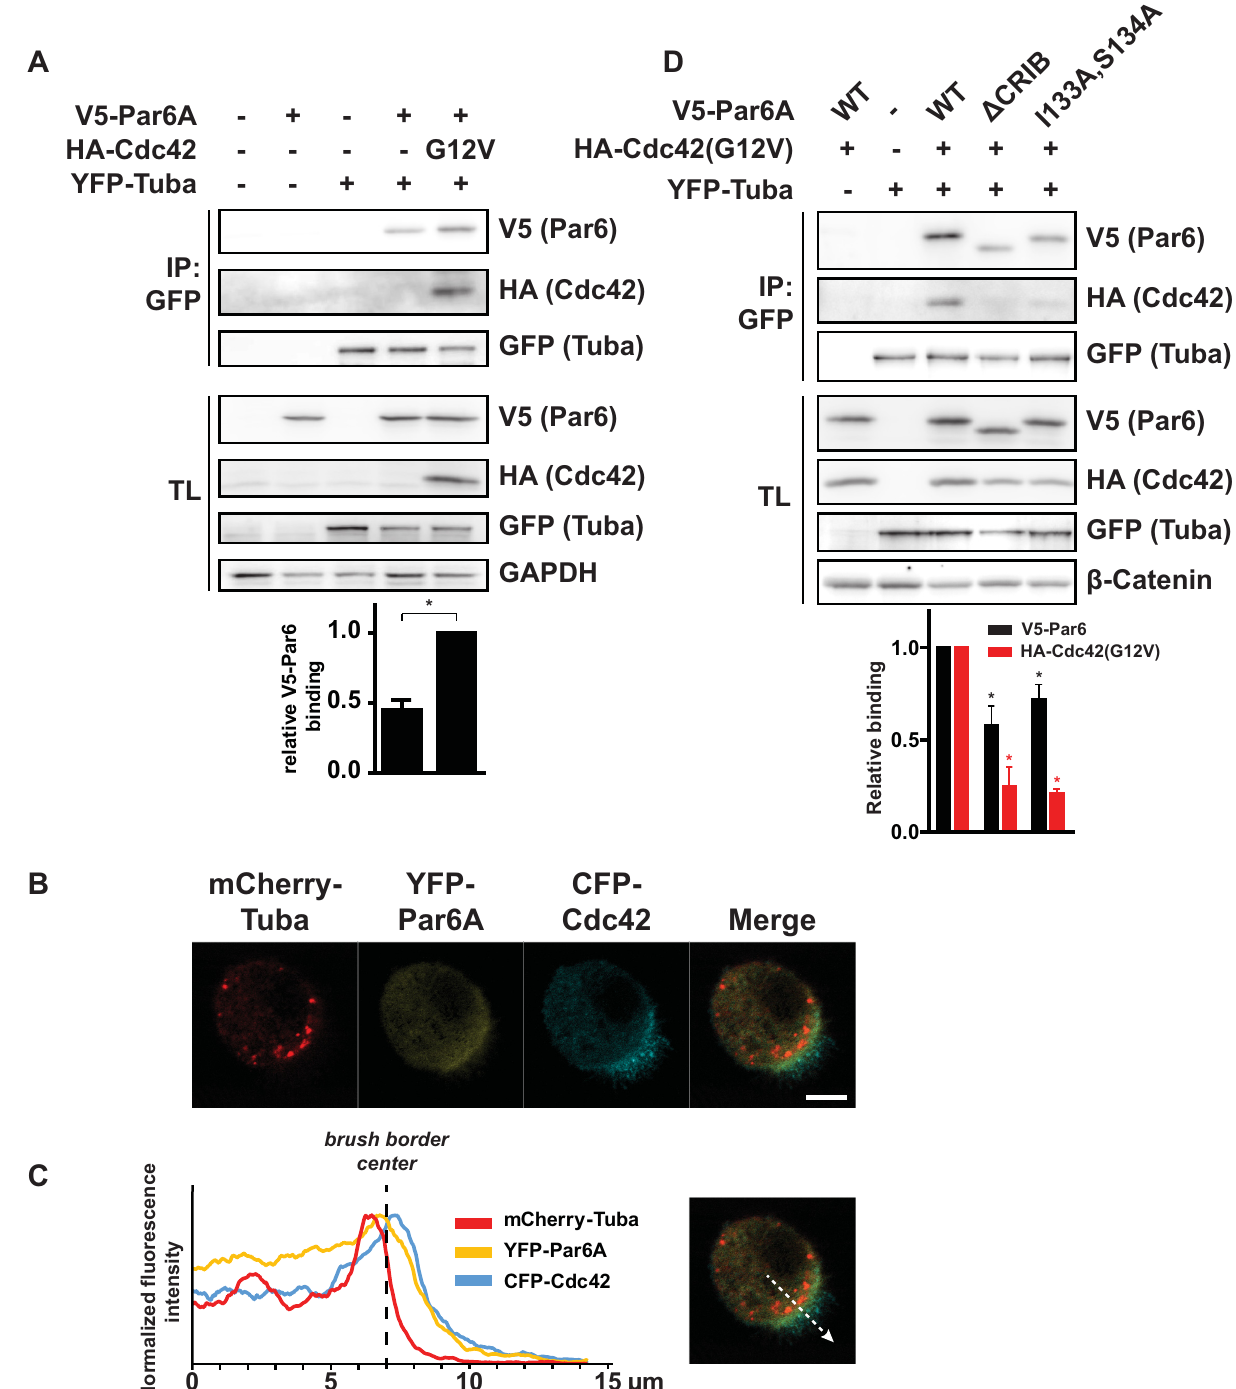
Fig 3. Par6A, Cdc42 and Tuba co-immunoprecipitate and colocalize at the apical domain in polarized Ls174T:W4 cells. A) Co- immunoprecipitation of V5-Par6A, HA-Cdc42(G12V) and YFP-Tuba in HEK293T cells. Bottom: quantification of relative V5-Par6 binding to YFP-Tuba in the presence and absence of HA-Cdc42(G12V). Error bars indicate s.e.m. (n = 3) � p < 0,05 using paired samples t-test. B) Localization of mCherry-Tuba, YFP-Par6A and CFP-Cdc42 in polarized Ls174T:W4 cells. Scale bar indicates 5 μ m. C) Left: Plot of average normalized fluorescence intensities of mCherry-Tuba, YFP-Par6A and CFP-Cdc42 in an apical section of 6 cells. Right: example of apical section used to generate average line scan. D) Co-immunoprecipitation of V5-Par6A, either WT, Δ CRIB or I133A,S134A with HA-Cdc42(G12V) and YFP-Tuba in HEK293T cells. IP = immunoprecipitation, TL = total lysate, WT = wild type. Bottom: quantification of relative V5-Par6 and HA-Cdc42(G12V) binding to YFP-Tuba. Error bars indicate s.e.m. (n = 4) � p < 0,05 using paired samples t-test.